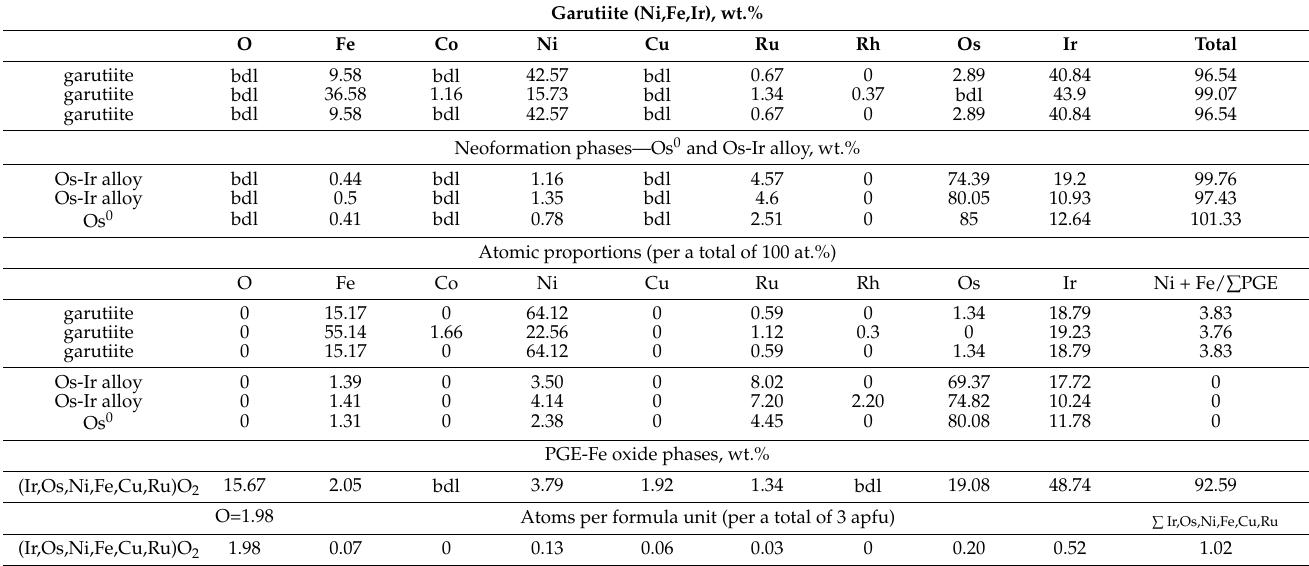
Table 4. Compositions of the second type of rim of PGM in grains of Ru-Os-Ir alloy minerals from the placer of the Kitoy River. Garutiite (Ni,Fe,Ir),